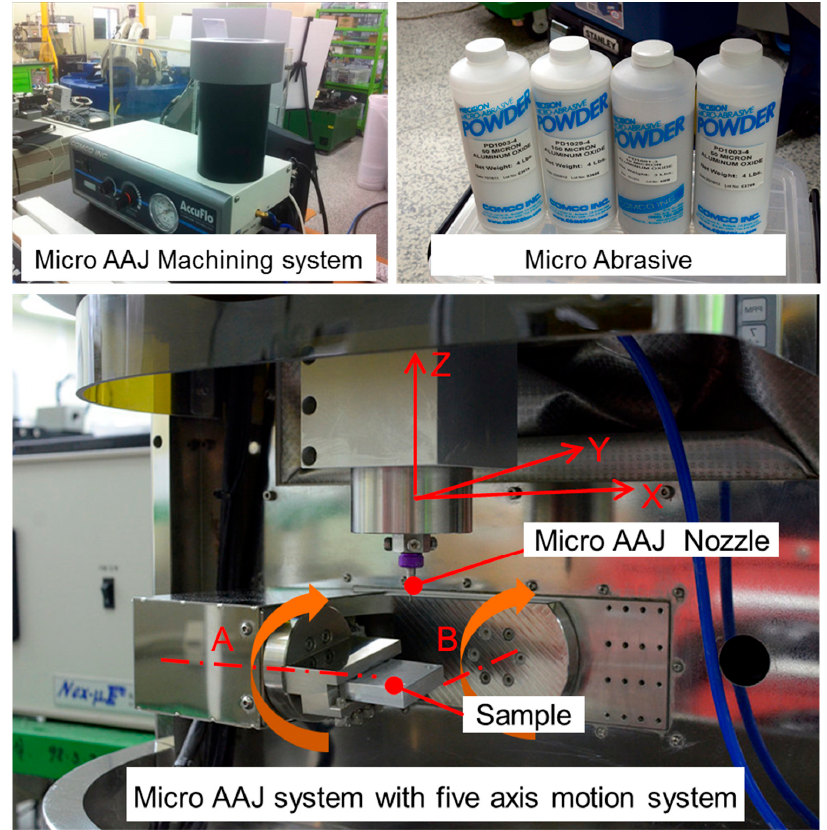
Figure 2. Micro-AAJ machining system including a five-axis positioning system.